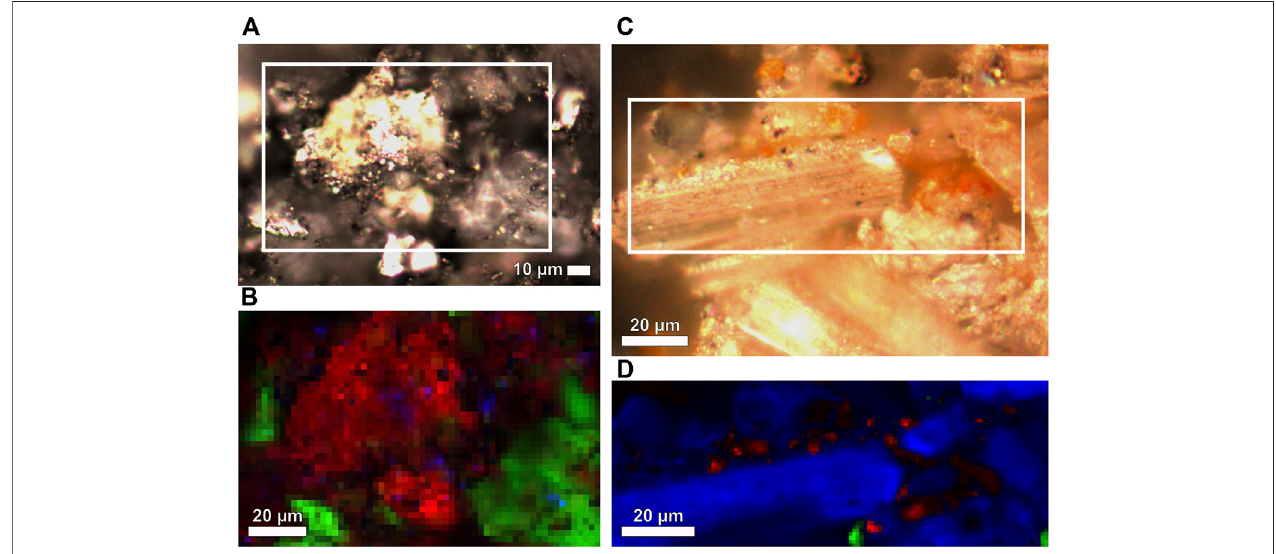
FIGURE 6 | Optical and Raman microspectroscopy of samples C1 and C2. Microscope images and Raman spectral maps are shown for samples C1 (A , B) and C2 (C , D) . The white rectangles in microscope images show where maps were collected. The map for sample C1 shown in B is colorized to match fi ts for pyrite (red; 375 – 380 cm − 1 ), gypsum (green; 1,000 – 1,020 cm − 1 ), and the G-band of organic carbon (blue; 1,500 – 1,650 cm − 1 ). Quartz, S 0 , anhydrite, hematite, calcite, and silicon were also found in this map region (see text). The map for sample C2 shown in (D) is colorized to match fi ts for pyrite (red; 365 – 375 cm − 1 ), S 0 (green; 205 – 225 cm − 1 ), and gypsum (blue; 1,000 – 1,020 cm − 1 ). This map region also contains anhydrite and organic